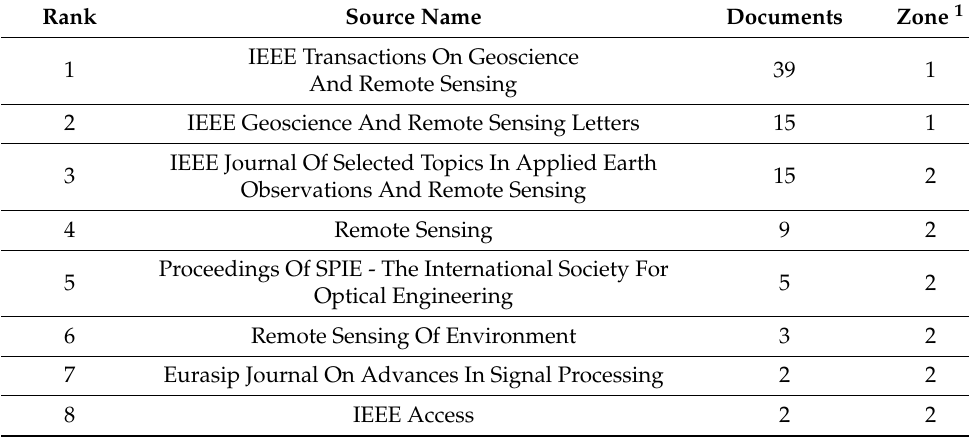
Table 2. The most relevant sources (first two zones by Bradford’s law [25]), sorted in descending order by the number of documents.